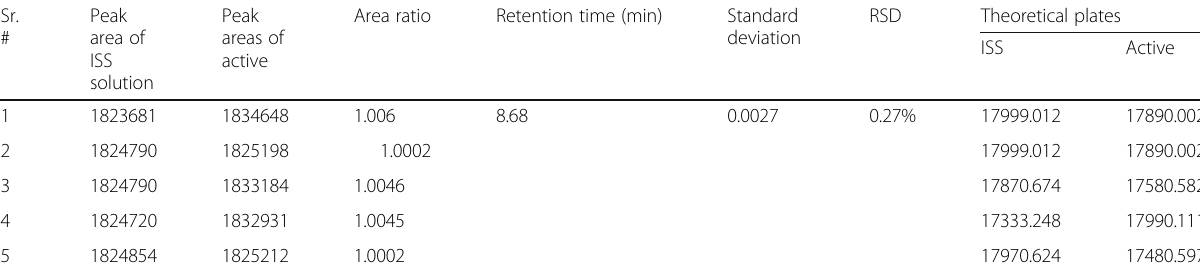
Table 1 Conclusive data with peak areas and standard deviation for system suitability Sr.